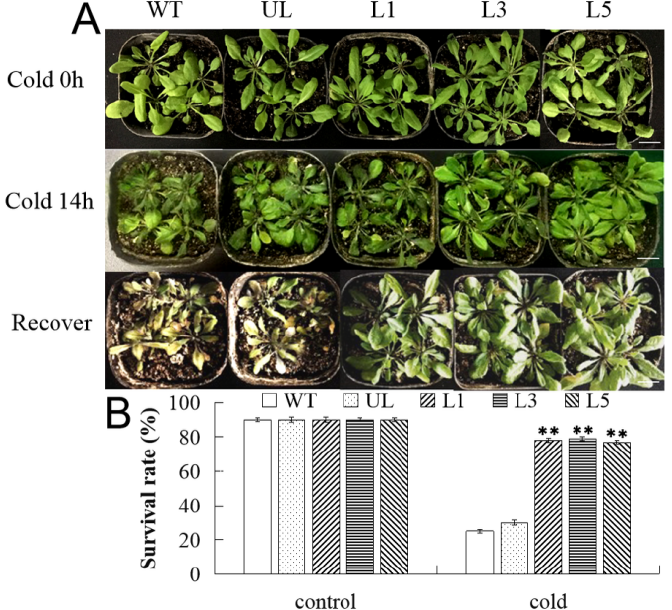
Figure 8. Growth of transgenic A. thaliana overexpressing FvMYB82 under low-temperature treatment. ( A ) Phenotypes of WT, transformants with empty vector (UL), and FvMYB82 -overexpressing lines (L1, L3, and L5) under the control environment (22 ◦ C), cold treatment (4 ◦ C), and after recovery. Bar = 1 cm. ( B ) Survival rate of WT, UL, and transgenic lines under the control environment and cold treatment. Three replicates were performed. Asterisks indicate a significant difference between the different lines (** p ≤ 0.01).